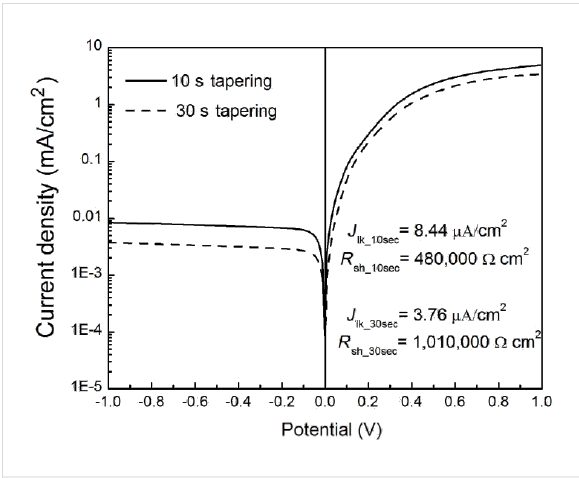
Figure 14: Current–potential characterization of the diodes with SiNW arrays tapered for 10 s (solid line) and 30 s (dashed